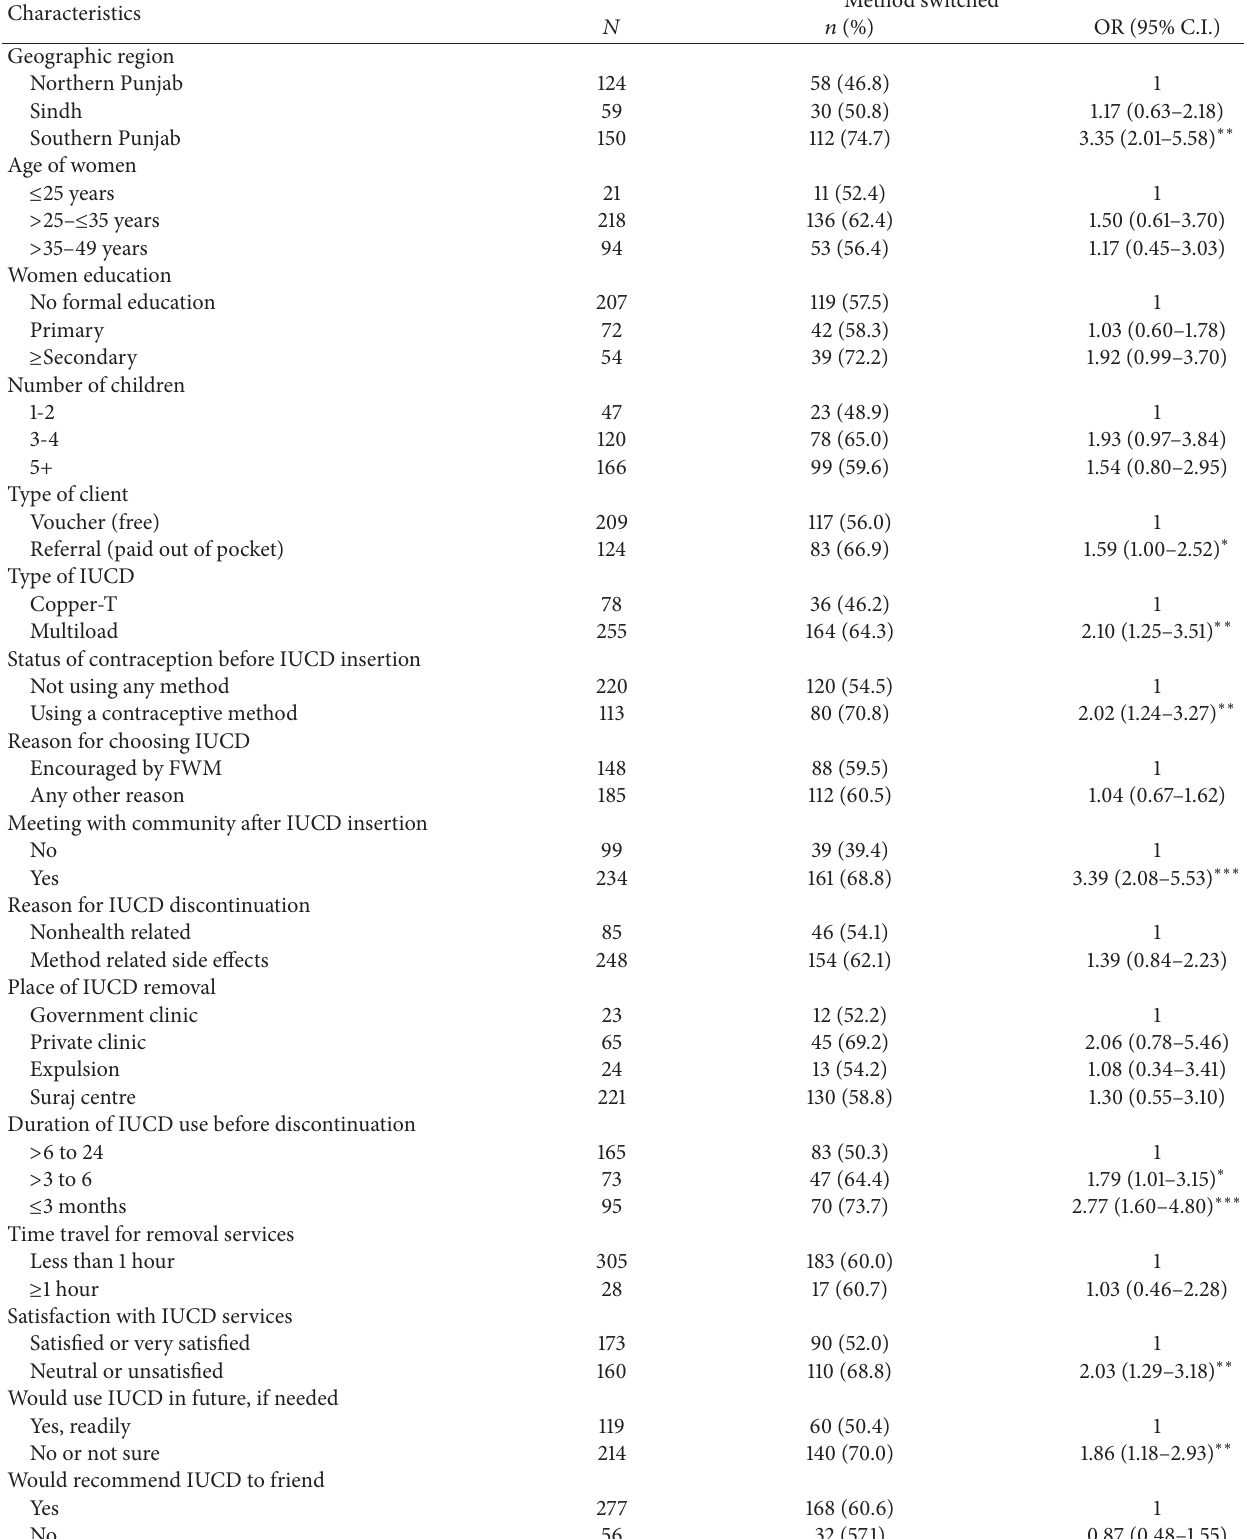
Table 3: Unadjusted odds ratios of method switching versus method stopping, according to selected sociodemographic and reproductive health risk